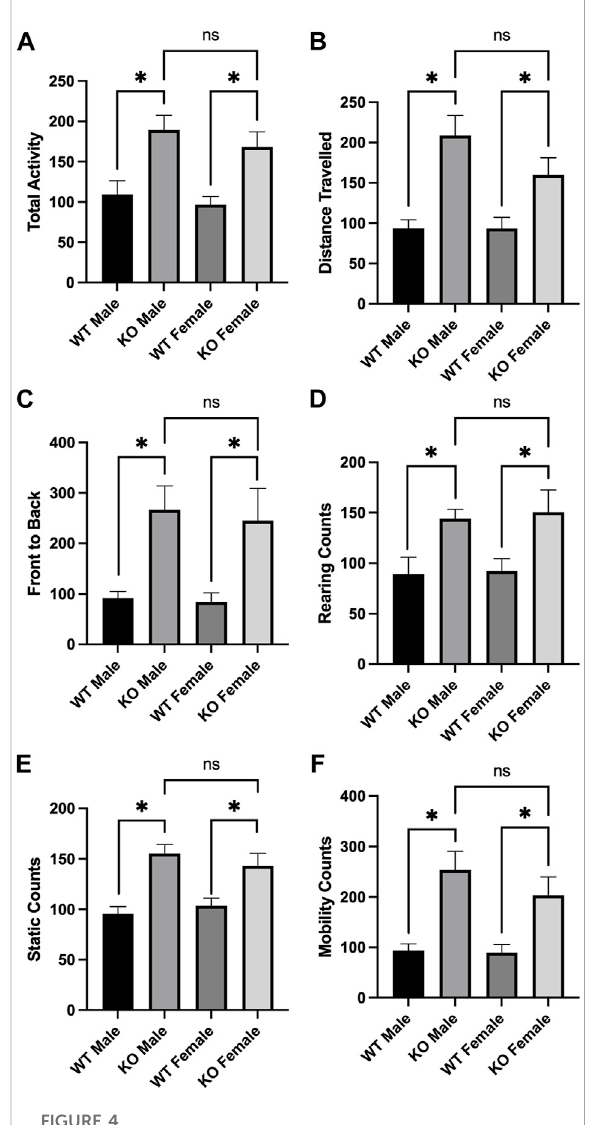
FIGURE 4 AMPHtreatmentinducedlocomotoractivityinSirt3-KOmale and female mice in the open fi eld. (A — F) Histograms showing the mean and SEM of behavioral performances of WT and Sirt3-KO male and female mice in different open- fi eld assessments treated with either saline or 1 mg/kg AMPH during a 30-min period. Parameters assessed were: (A) total activity, (B) distance travelled, (C) front to back, (D) rearing counts, (E) static counts and (F) mobility counts. Data are presented as the behavioral output observed in subjects that received AMPH normalized to those that received saline injection (A — F) . AMPH treatment elevated all assessed behavioral parameters in both male and female Sirt3-KO mice,relativetosalinegroup.Asterisksdenote.( p < 0.05),two-way ANOVA (male independent subjects: saline n = 6, AMPH n = 7; female independent subjects: saline n = 8, AMPH n = 9).